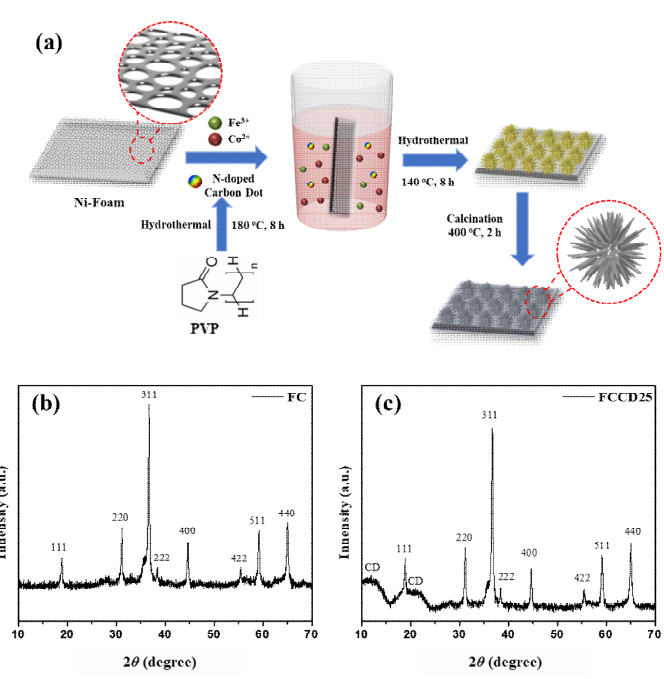
Figure 1. ( a ) Schematic description for the synthesis of FeCo 2 O 4 @CDs nanoflowers, XRD pattern for ( b ) FC and ( c ) FCCD25. ( b ) FC and ( c ) FCCD25.